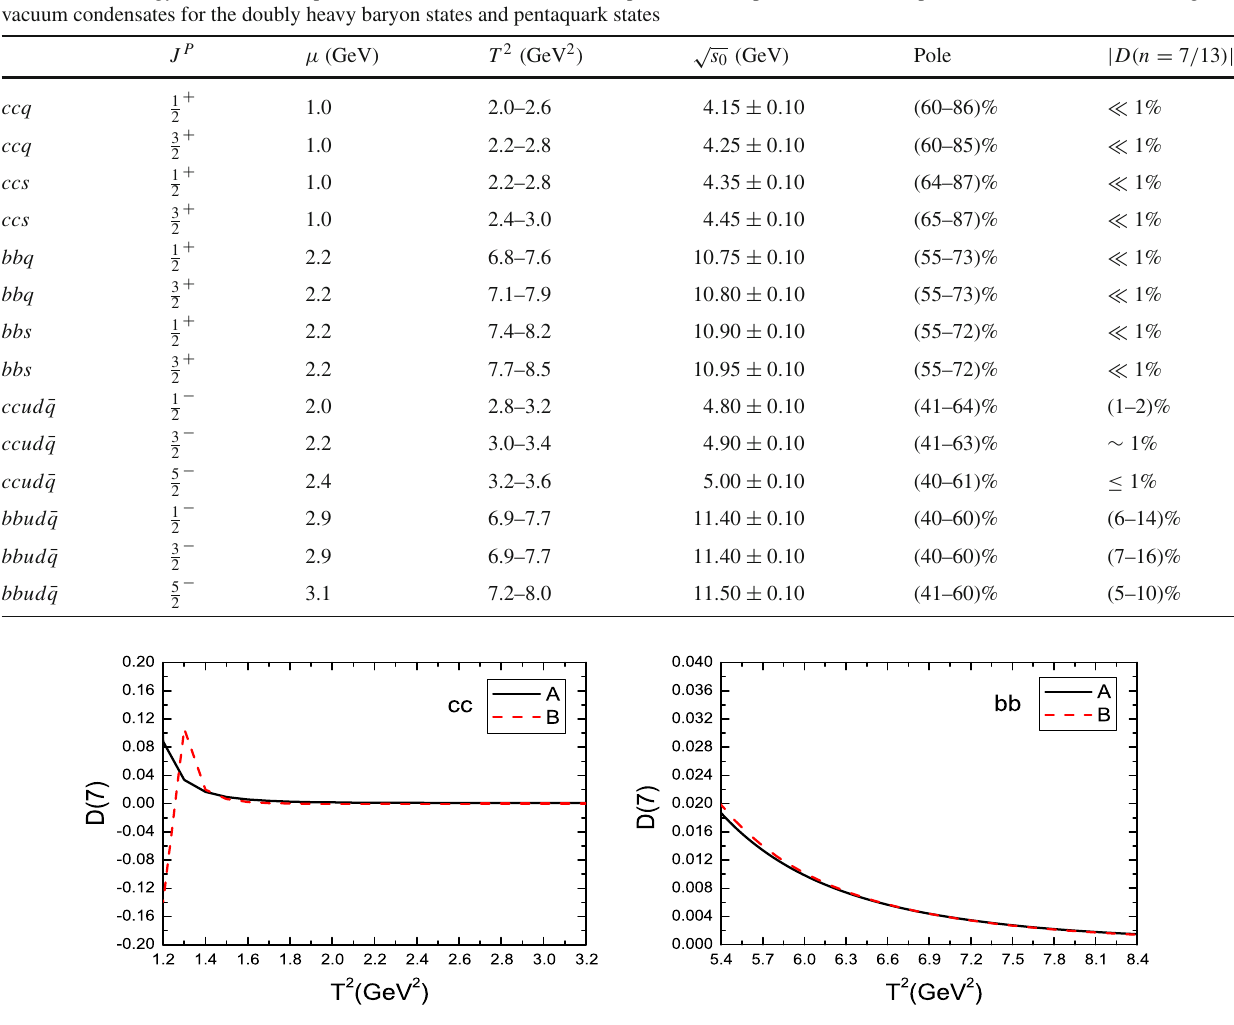
Fig. 1 The contributions of the vacuum condensates of dimension 7 in the operator product expansion, where A and B denote the (cid:2) QQ baryon states with J = 1 and 3 , 2 2